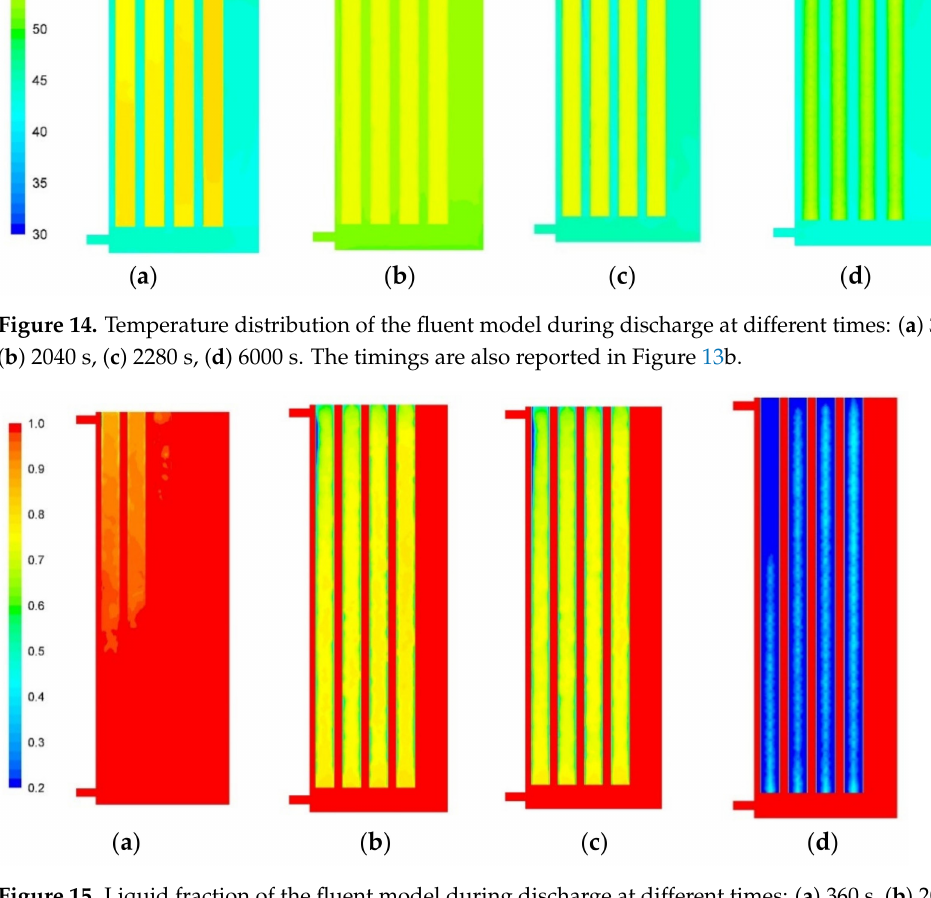
Figure 15. Liquid fraction of the fluent model during discharge at different times: ( a ) 360 s, ( b ) 2040 s, ( c ) 2280 s, ( d ) 6000 s. The timings are also reported in Figure